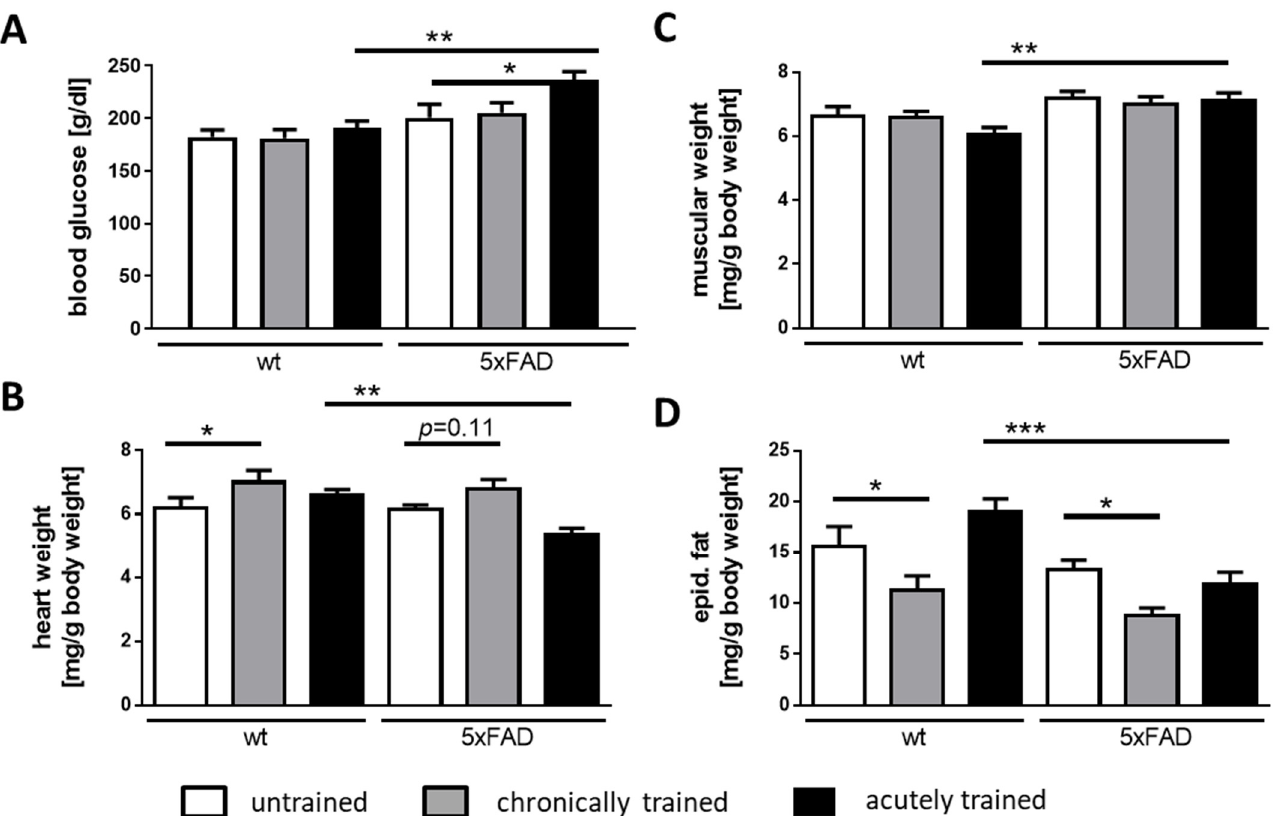
Figure 3. Physical parameters in 5xFAD and wild-type mice after different activity regimens. Upon sacrifice, truncal blood glucose was measured ( A ) and Gastrocnemius of both hind legs ( B ), heart ( C ), and abdominal fat ( D ) were dissected and weighed. Data are presented as mean + SEM ( n = 6 for untrained and acutely trained, n = 7 for chronically trained mice). Statistical analysis: ordinary one-way ANOVA with the Fisher LSD test (* p < 0.05; ** p < 0.01; *** p < 0.001).